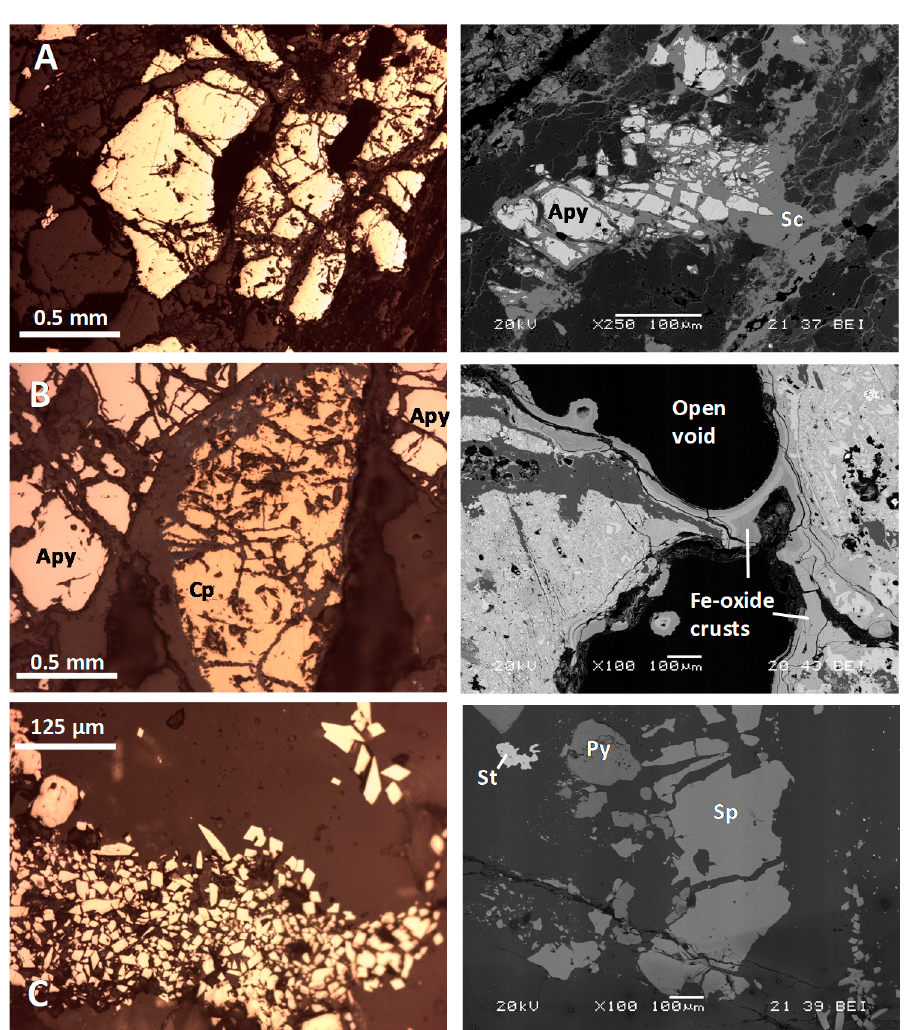
Figure 3. Mine wastes microtexture. Each line combines pairs of images captured by optical microscopy (left column) with SEM backscattered-electron images (right column). ( A ) Rita mine: Individual arsenopyrite crystals (left image) and scorodite (Sc) neoformation (from arsenopyrite (Apy) weathering (right image). ( B ) Tres Amigos mine: Primary arsenopyrite (Apy) and chalcopyrite (Cp, left), and iron oxide crusts partially filling open spaces (right). ( C ) Las Viescas mine: Idiomorphic arsenopyrite crystals in a calcite gangue (left) and disperse sphalerite (Sp)-pyrite (Py)-stibnite (St) (right).